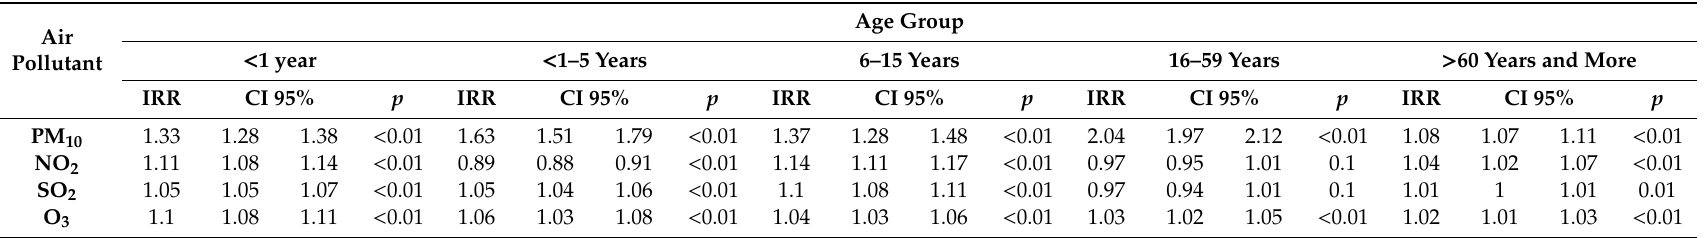
Table 4. Results using Poisson Models for panel e ff ects with population averages by atmospheric pollutant and age group for respiratory diseases, 2013–2016